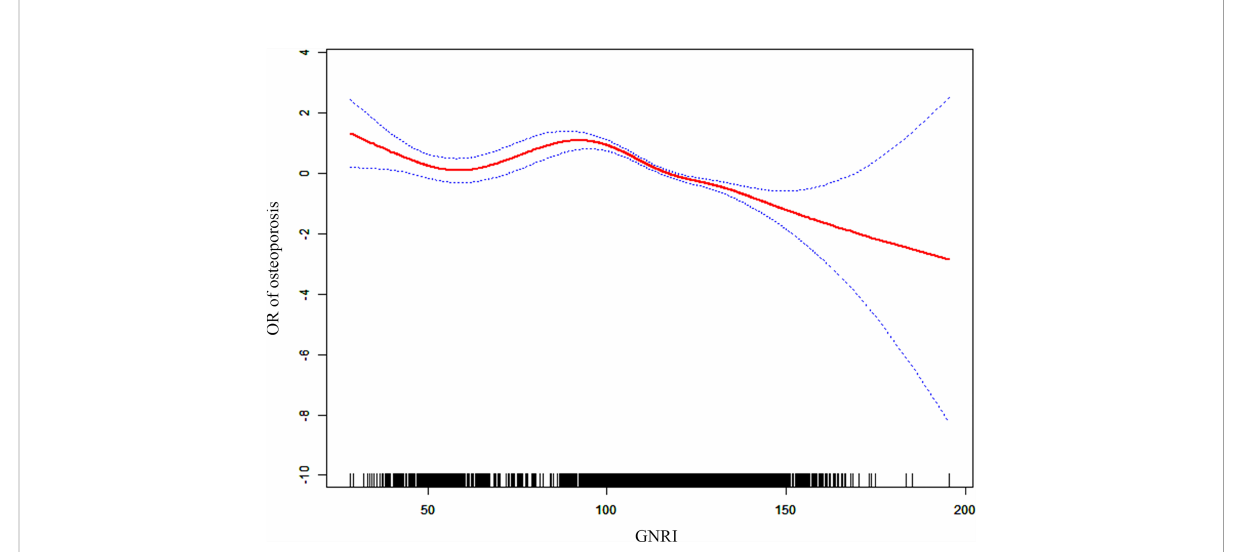
FIGURE 4 Dose-response association between OR of osteoporosis and GNRI (adjusted for age, sex, race, smoker, alcohol user, glucocorticoid user, hypertension, cancer, and